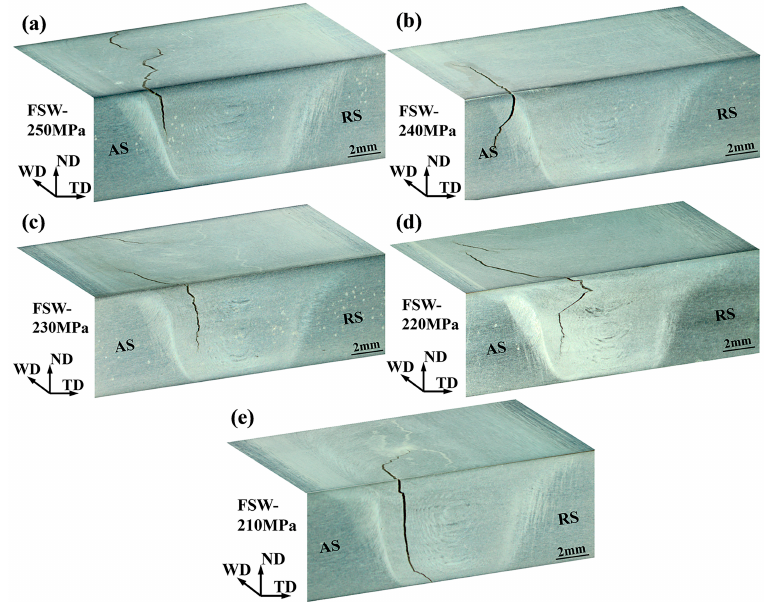
Figure 7. S–N diagram of the FSW and UAFSW specimens.